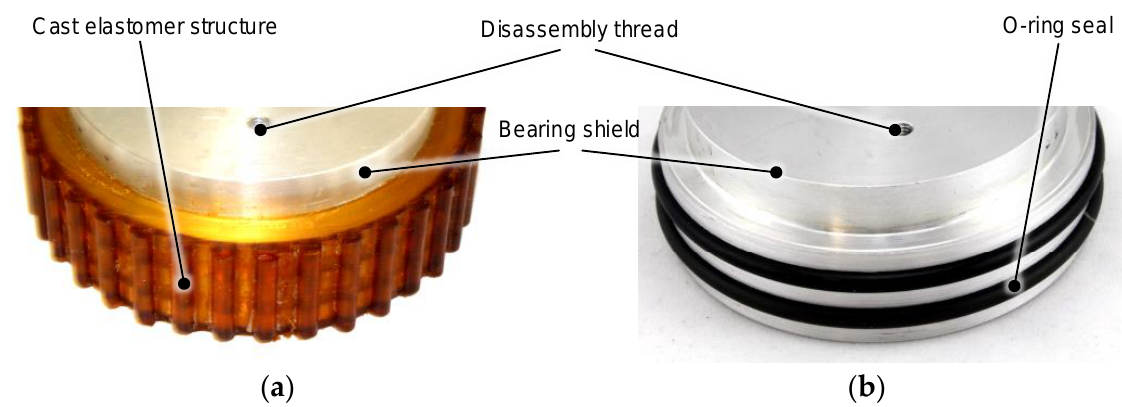
Figure 5. Resilient suspension design: ( a ) casted elastomer; ( b ) O-ring seals. Approximate values for stiffness and damping of O-ring seal solutions may be found in the literature [32,33]. For accurate design and validation, empirical determination of suspension properties is required. Since stiffness and damping are both frequency dependent an approach is described that allows the determination of both values as a function of frequency. The approach is based on the half power bandwidth method . A solid shaft connects both bearing shields as illustrated in Figure 6a,b. There are no bearings included in this setup since the suspension stiffness is significantly lower than the stiffness of the bearings. Therefore, the overall stiffness is primarily determined by the resilient bearing seat. The resonance frequency of this test setup (and consequently the frequency at which the properties are determined) can be modified by changing the mass of the shaft connecting the bearing shields. An electro-mechanic shaker is used to excite the setup and an accelerometer measures the acceleration of the shaft.